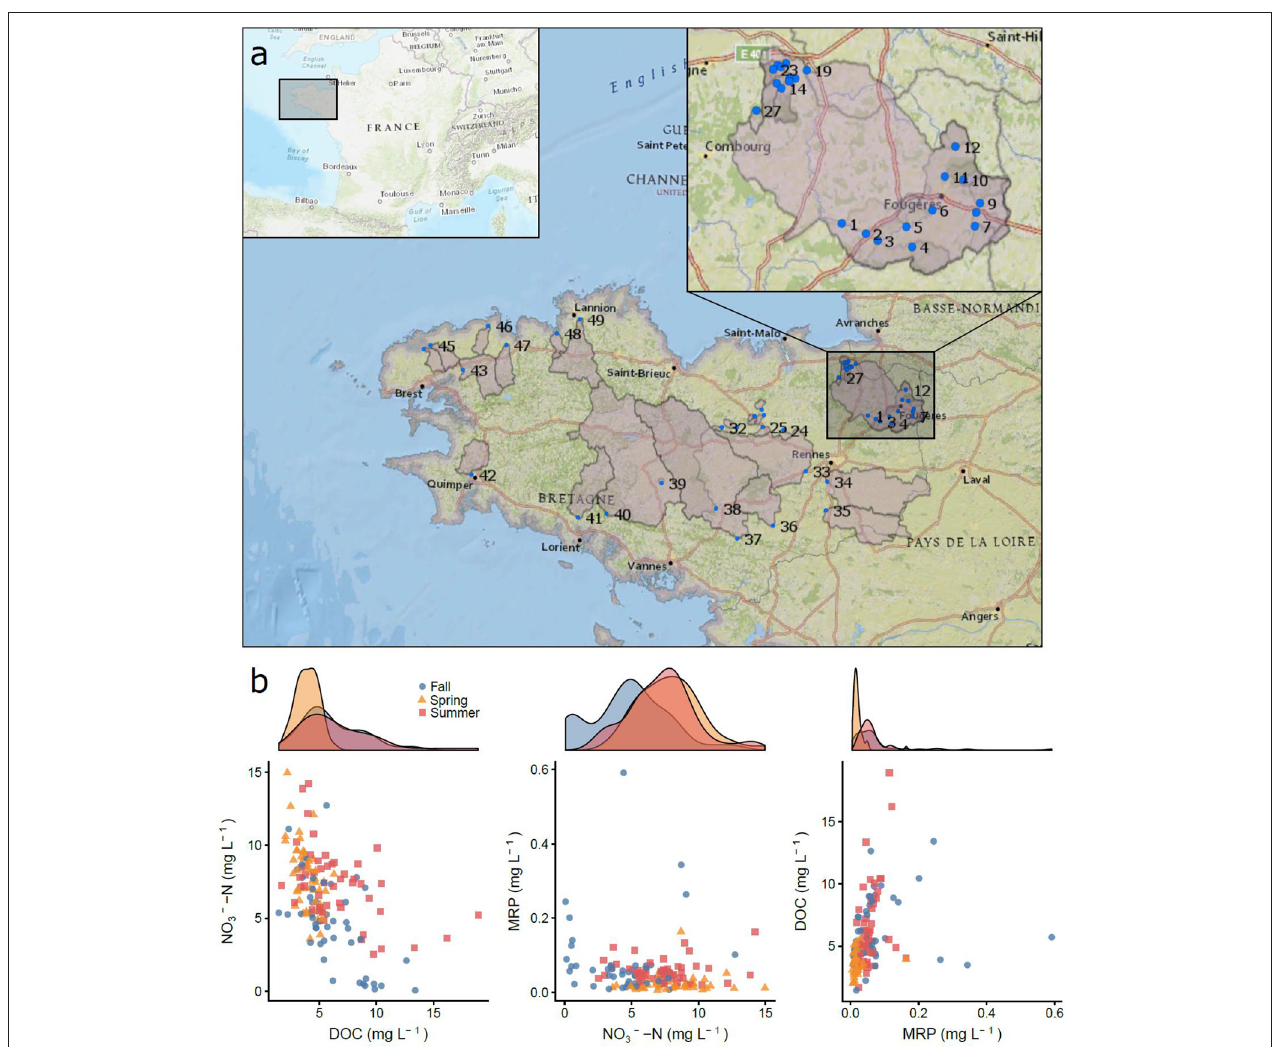
FIGURE 2 | (a) Location of the 49 watersheds sampled during the 3 field campaigns (November 2015, March 2016, and June 2018) in Brittany, France. The Couesnon watershed is enlarged to show the 23 nested watersheds in greater detail. (b) Distribution of nutrient concentrations for dissolved organic carbon (DOC), nitrate (NO − 3 ), and Molybdate-Reactive Phosphorus (MRP). Density plots above the Cartesian planes show seasonal shifts in nutrient concentrations along the